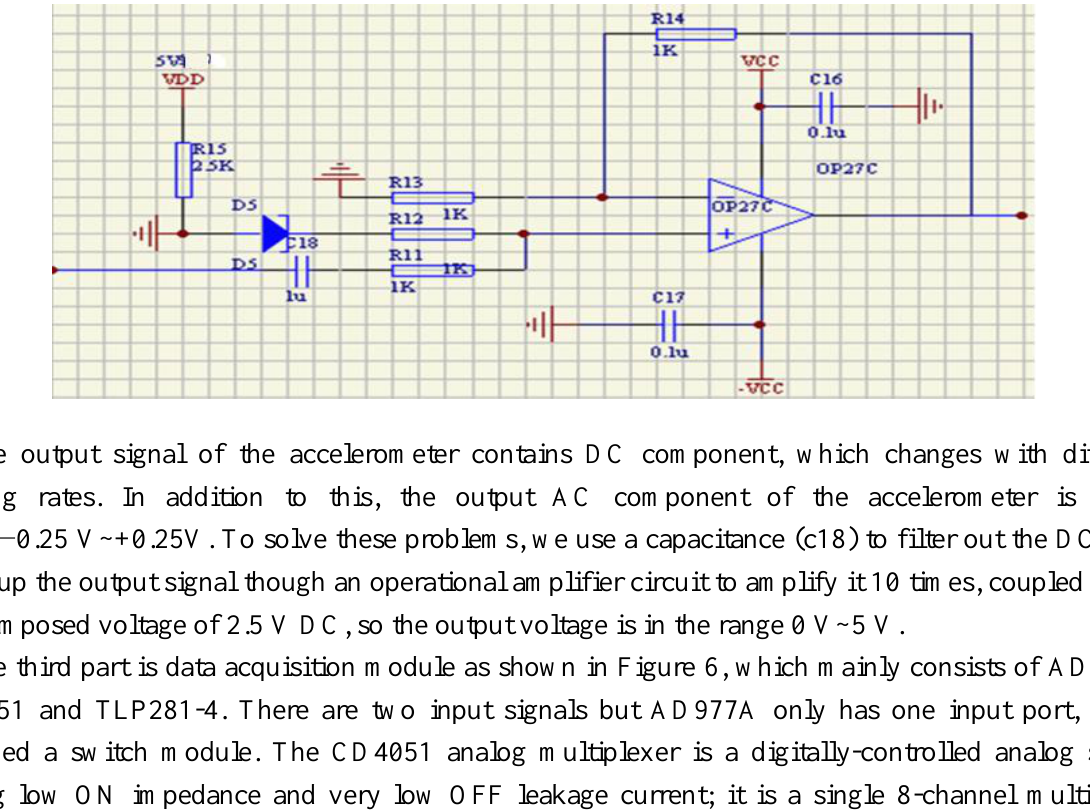
Figure 5. The accelerometer signal pretreatment circuit.